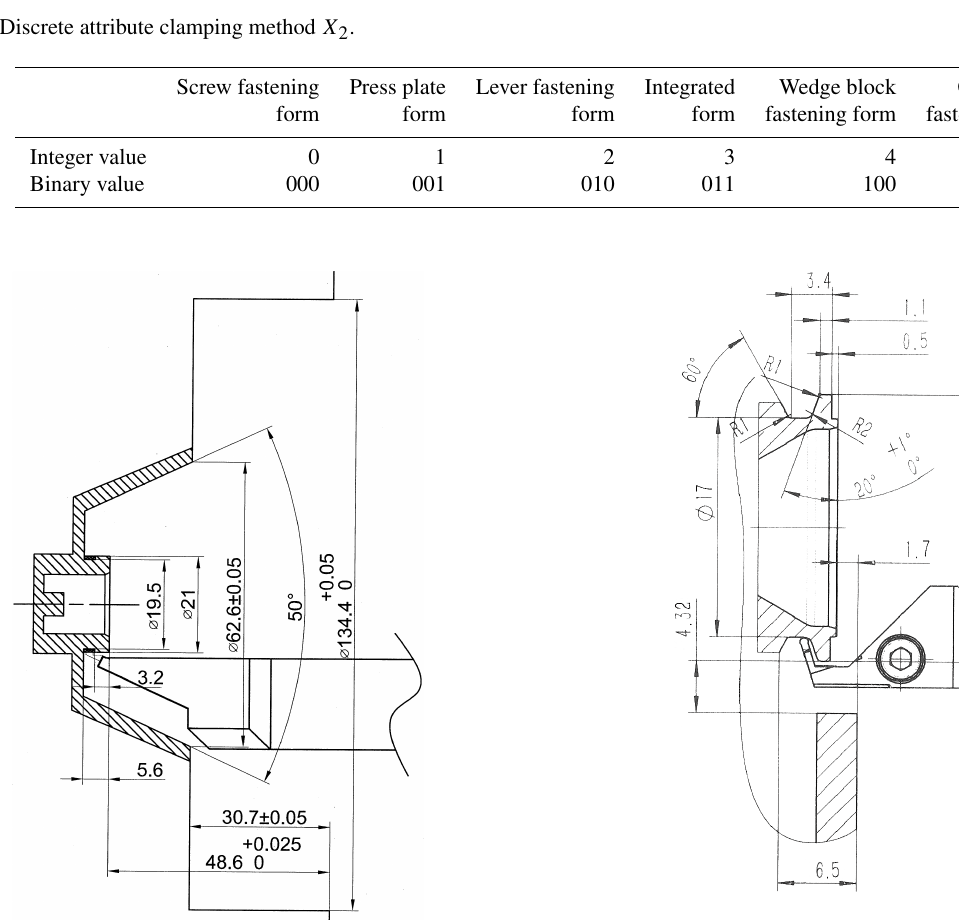
Figure 5. Sample A0002 part slot